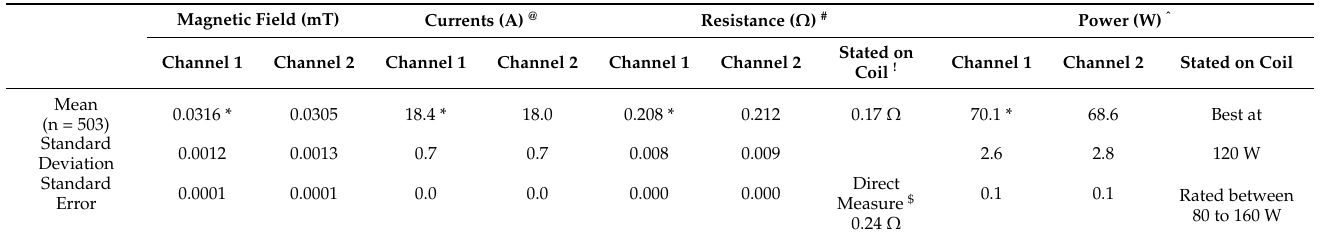
Table 2. Statistics of Magnetic and Electrical Coil Properties after the First Five Puffs.